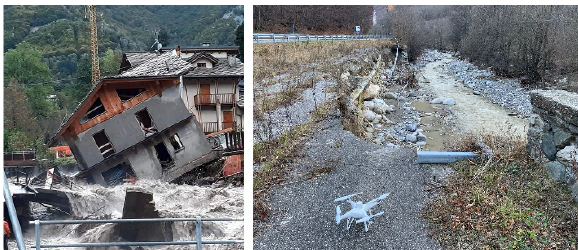
Figure 1. Some of the damages of October 2020 flood in the area of Limone Piemonte, Piemonte region,